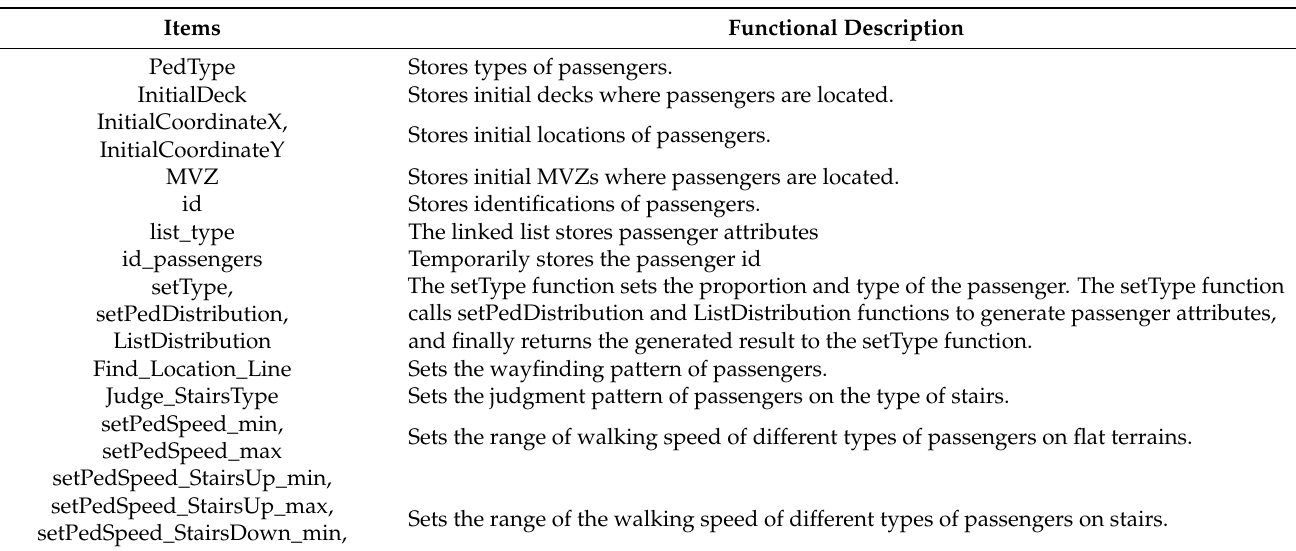
Table A3. The detailed descriptions of parameters, variables, and functions in the passenger